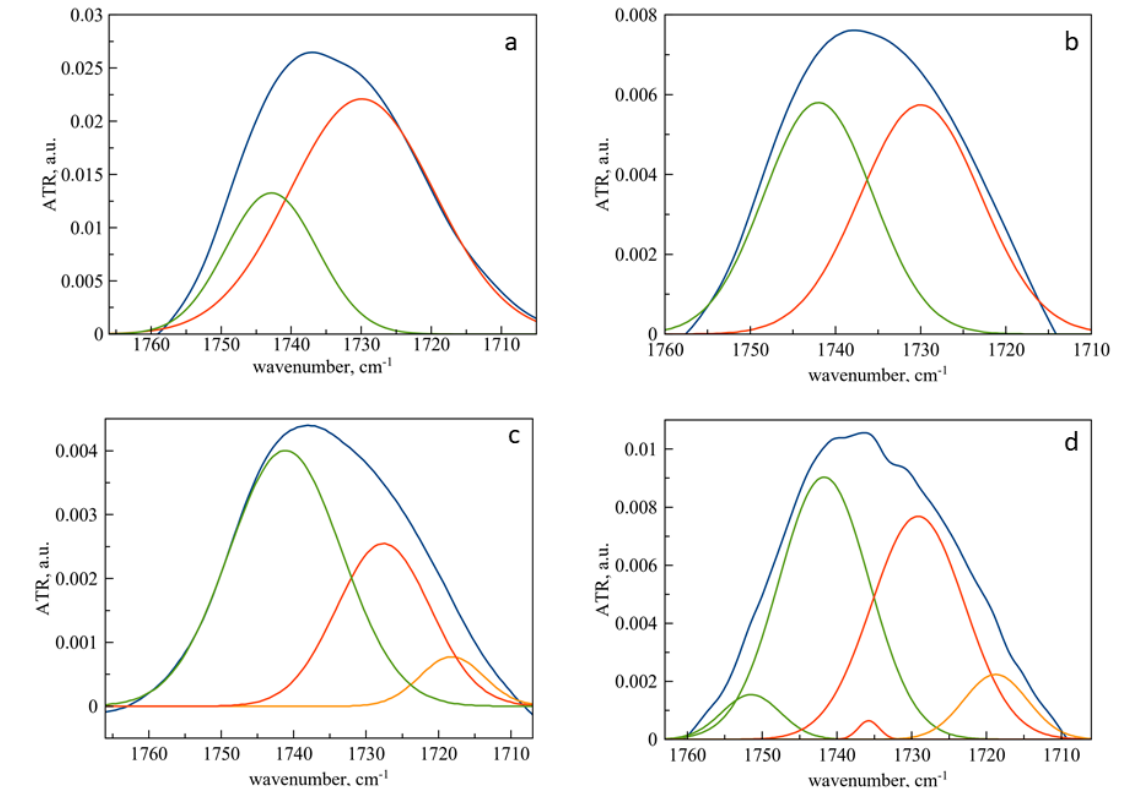
Figure 2. ATR-FTIR spectra of liposomes and liposomal forms of pirfenidone: carbonyl group area. Deconvolution was conducted with Gaussians. The blue line is the initial spectrum, green—component of low hydrated carbonyl groups, red—component of medium hydrated carbonyl groups, orange—component of high hydrated carbonyl groups. ( a ) DPPC liposomes. ( b ) DPPC liposomes, loaded with pirfenidone. ( c ) DPPC:Chol 90:10 liposomes. ( d ) DPPC:Chol 90:10 liposomes, loaded with pirfenidone. 0.02 M sodium-phosphate-buffered solution pH 7.4. Figure 2 show the results of deconvolution of the spectra of liposomes and liposomal forms of pirfenidone. Quantitative data on the redistribution of carbonyl groups by degrees of hydration are presented in Table 4. For monocomponent DPPC liposomes, the absorption band of the carbonyl group consists of two components corresponding to the medium (1730 cm − 1 ) and low hydrated groups (1742 cm − 1 ). Moreover, the dominant form is